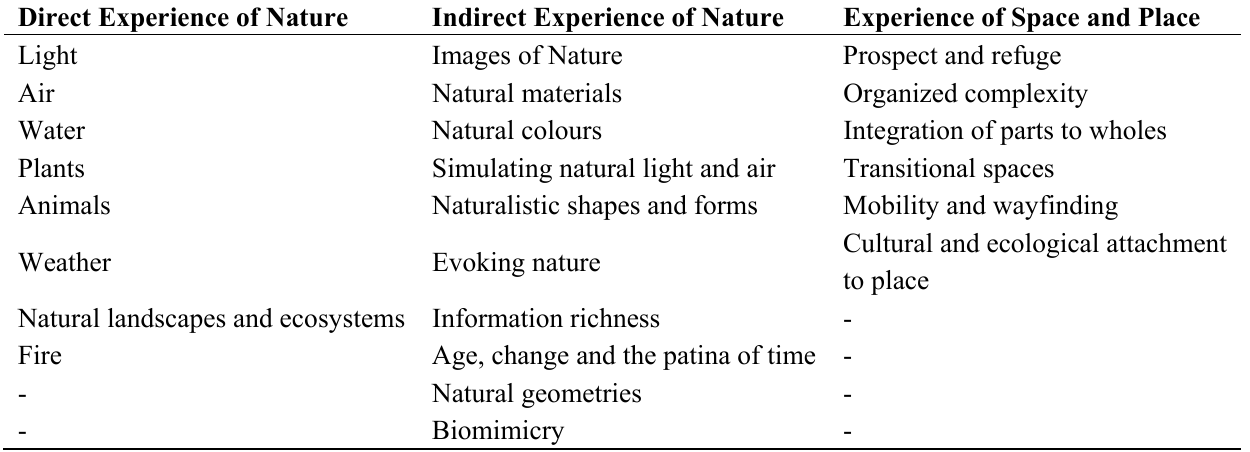
Table 1. Experiences and attributes of Biophilic design by Kellert and Calabrese [18]. Direct Experience of Nature Indirect Experience of Nature Experience of Space and Place Light Images of Nature Prospect and refuge Air Natural materials Organized complexity Water Natural colours Integration of parts to wholes Plants Simulating natural light and air Transitional spaces Animals Naturalistic shapes and forms Mobility and wayfinding Cultural and ecological attachment Weather Evoking nature to place Natural landscapes and ecosystems Information